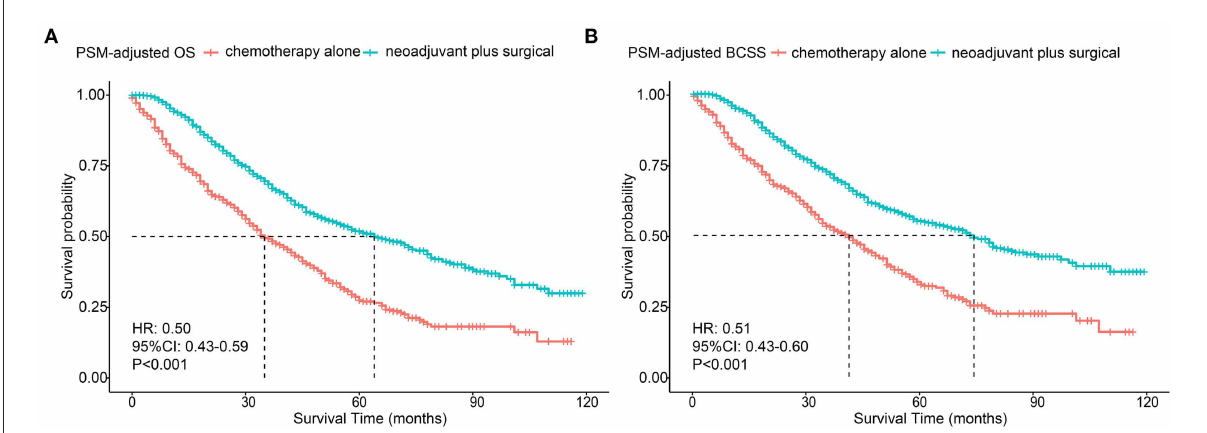
FIGURE2 PSM-adjusted OS and BCSS of BMBC patients with neoadjuvant chemotherapy plus surgical treatment and chemotherapy alone. Kaplan–Meier (K–M) survival analysis: (A) OS of BMBC patients with neoadjuvant chemotherapy plus surgical treatment and chemotherapy alone; (B) BCSS of BMBC patients with neoadjuvant chemotherapy plus surgical treatment and chemotherapy alone. PSM, Propensity score matching OS, overall survival; BCSS, breast cancer-specific survival; BMBC, bone metastatic breast cancer; HR, hazard ratio; CI, confidence